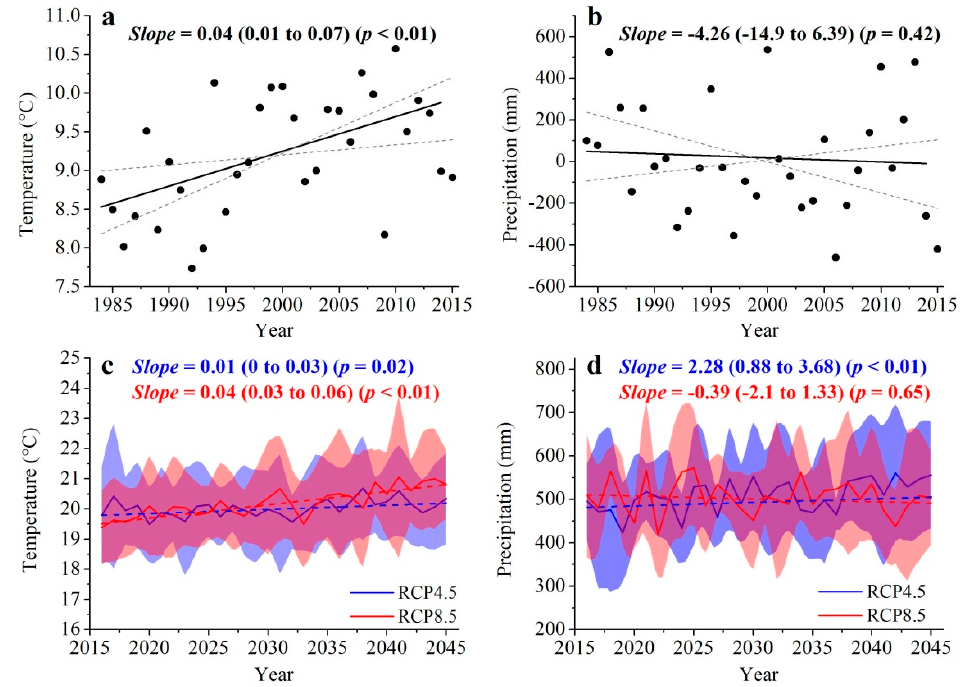
Figure 3. Trends in temperature ( a ) and precipitation ( b ) throughout the growing season (June, July, August, and September) on alpine tundra within the Changbai Mountains between 1984 and 2015. Dashed lines, the 5%–95% uncertainty range of the linear regression slope; the p value is the trend significance according to a Mann–Kendall test. Trends in temperature ( c ) and precipitation ( d ) throughout the growing season within multi-model ensembles for the same region under two RCP scenarios between 2016 and 2045. The shadow zones represented SDs for each index, respectively.